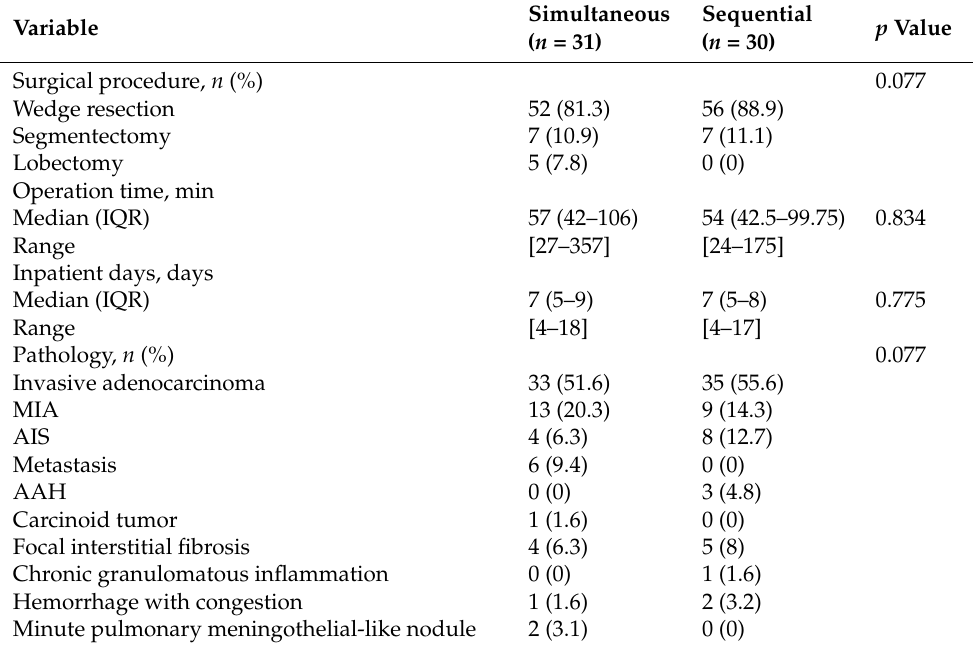
Table 4. Operative and pathological